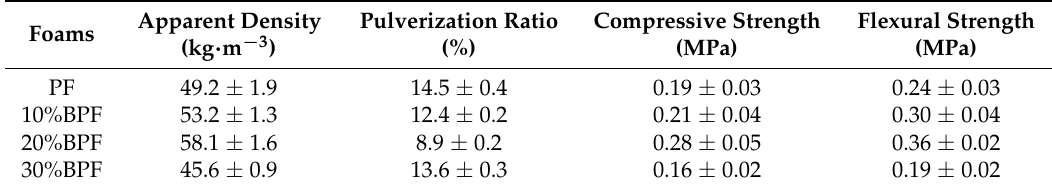
Table 4. Basic characteristics of PF and BPFs.